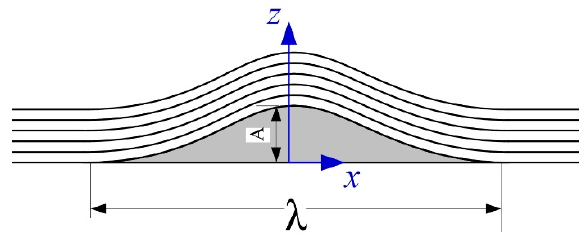
Figure 2. Uniform wrinkle model.